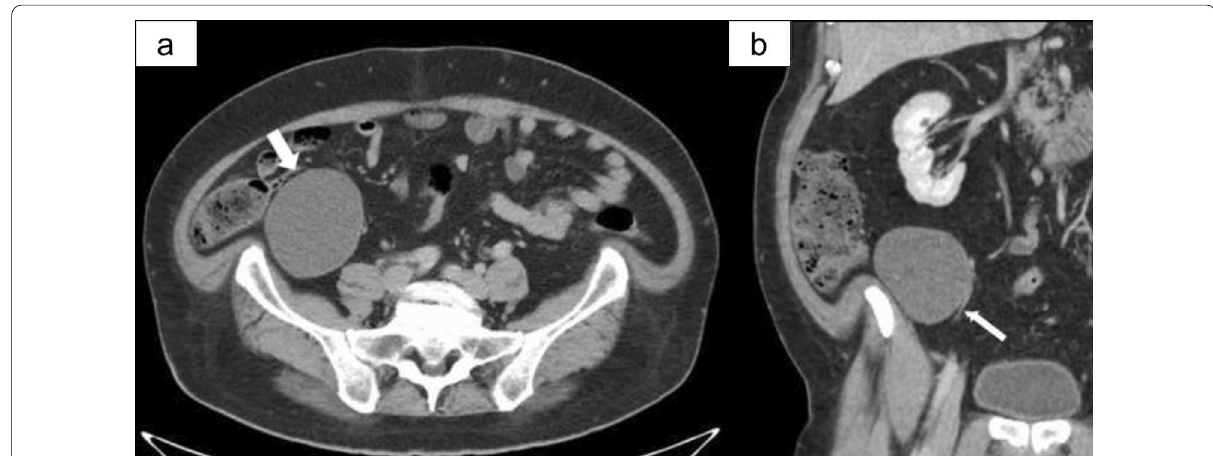
Fig. 1 Preoperative computed tomography. Enhanced computed tomography showed a unilocular cystic mass (thick arrow) of 10 cm in diameter located below the right kidney in the retroperitoneum ( a ), which appeared to be close to the appendix on the ventral side and to the right gonadal vessel (thin arrow) on the medial side ( b